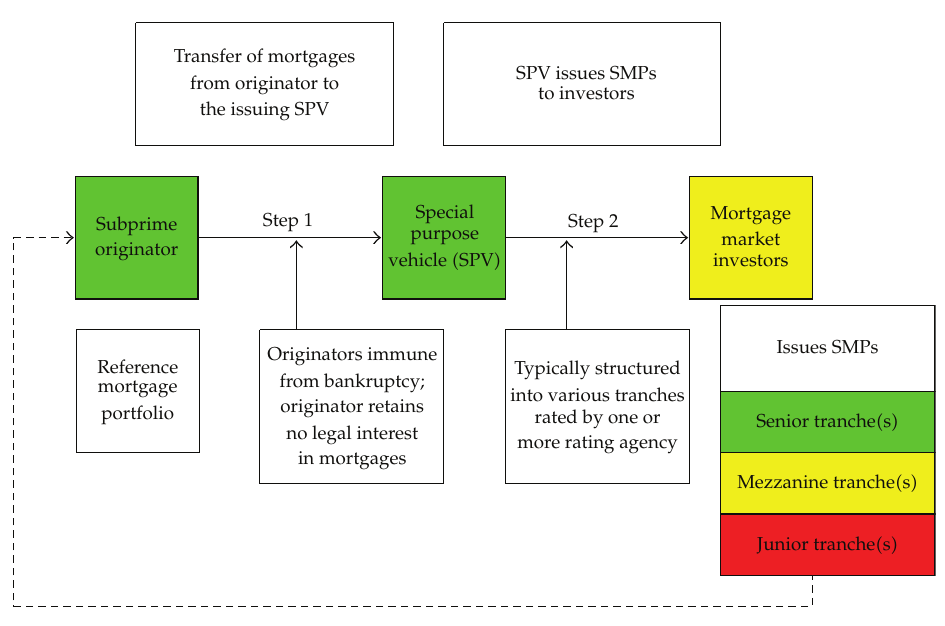
Figure 1: Diagrammatic overview of mortgage